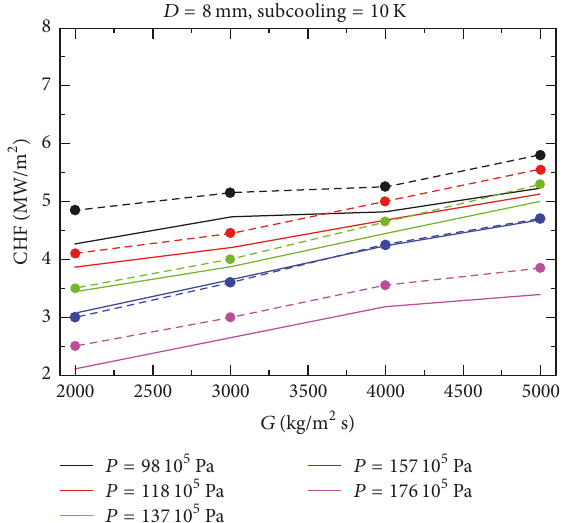
Figure 45: CHF calculated versus experimental CHF for several values of outlet quality. Experimental values are represented by points.